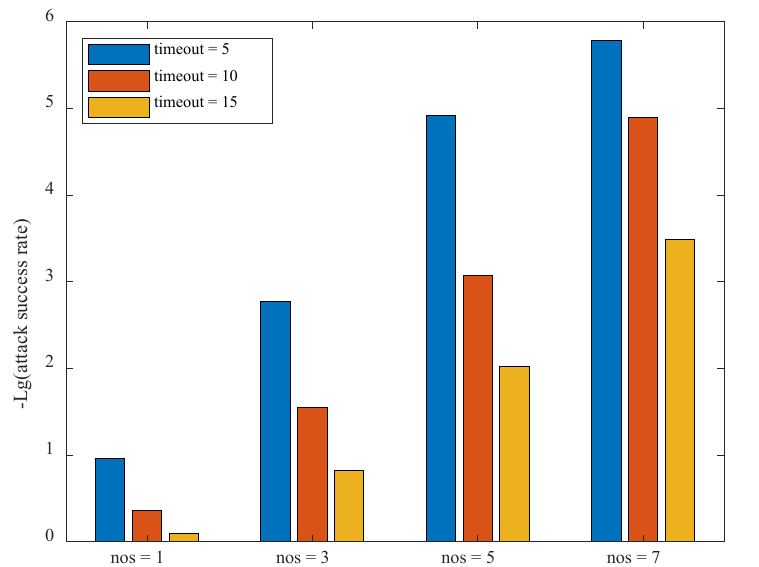
Figure 9. The change of attack success rate under different values of nos. (nos means the number of nodes in the active set.)